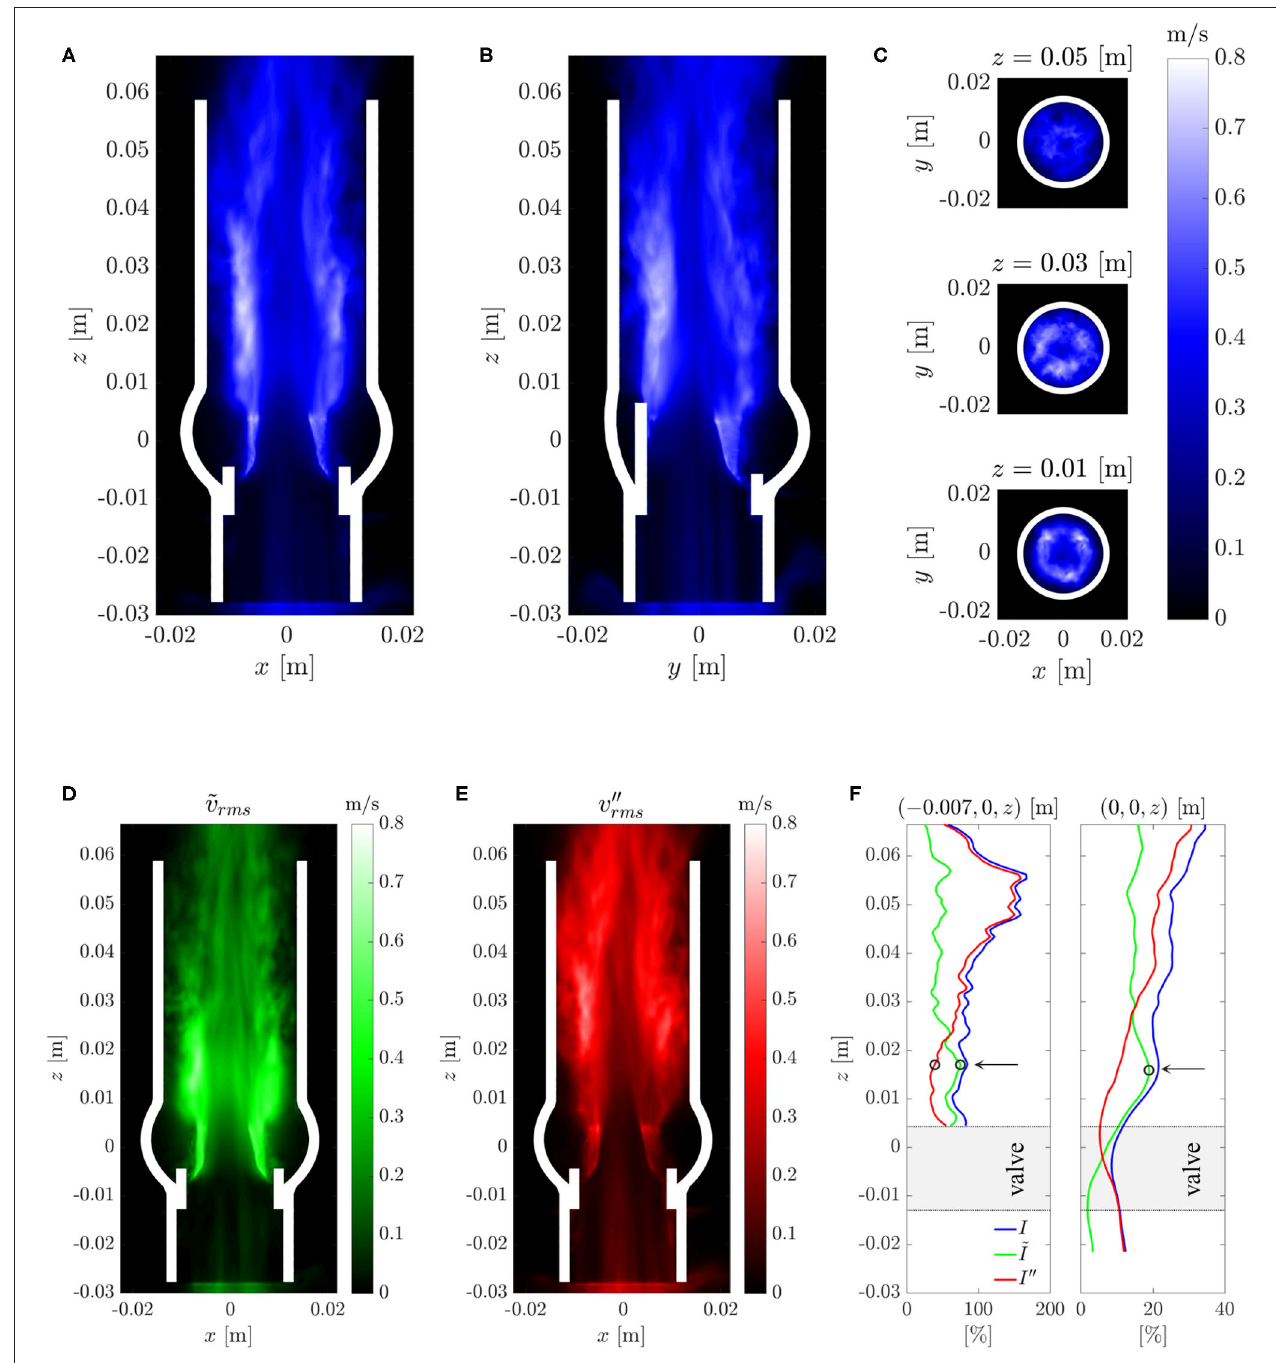
FIGURE 9 | (A–C) Root-mean-square velocity fluctuations v ′ rms in different cross-sections (same as in Figure 7 ). (D) Root-mean-square periodic fluctuations ˜ v rms and (E) root-mean-square turbulent fluctuations v ′′ rms . (F) Turbulent intensities I and I ′′ and the intensity ˜ I of the periodic fluctuations along an axial line in the shear layer (left) and along the centerline (right). The arrows and circles indicate the position of the peak intensity ˜ I of the periodic fluctuations and the begin of the growth of the turbulence intensity I ′′ within the shear layer.